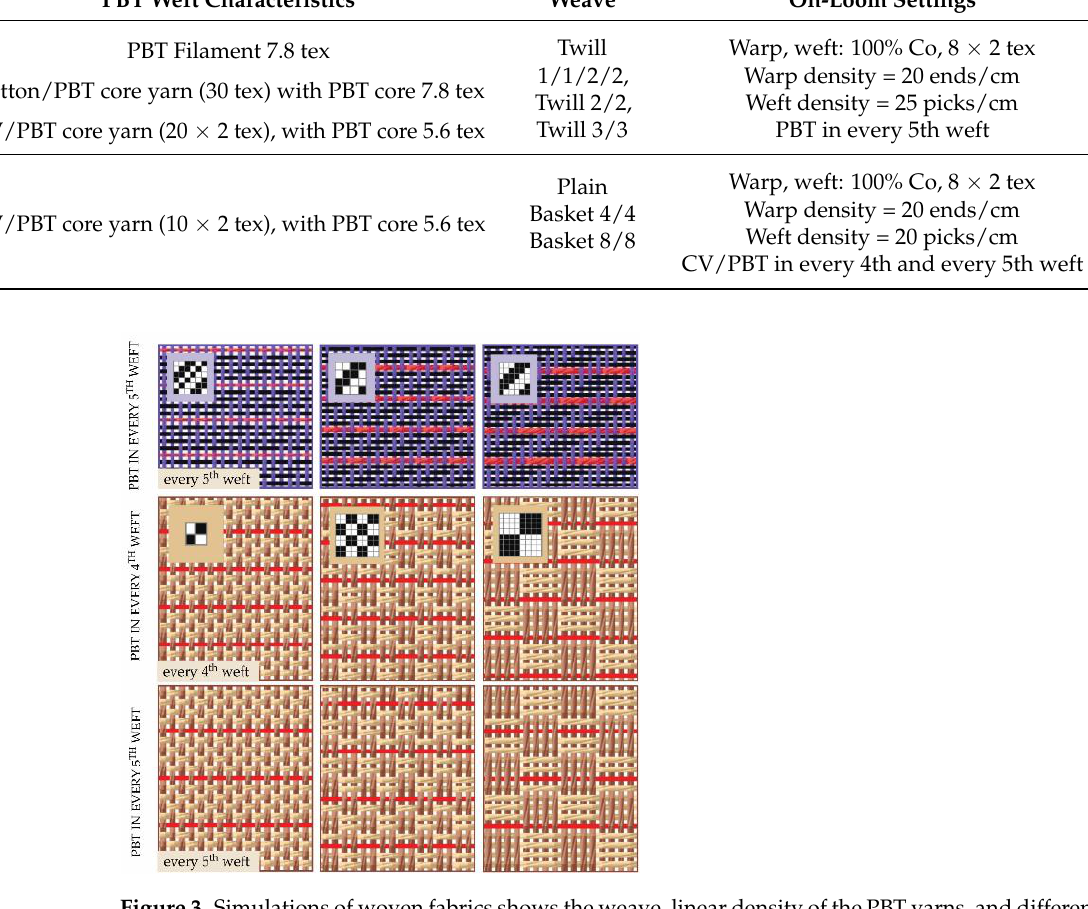
Table 1. Characteristics of samples to evaluate the effects of different float lengths and weft sequences. PBT Weft Characteristics Weave On-Loom Settings